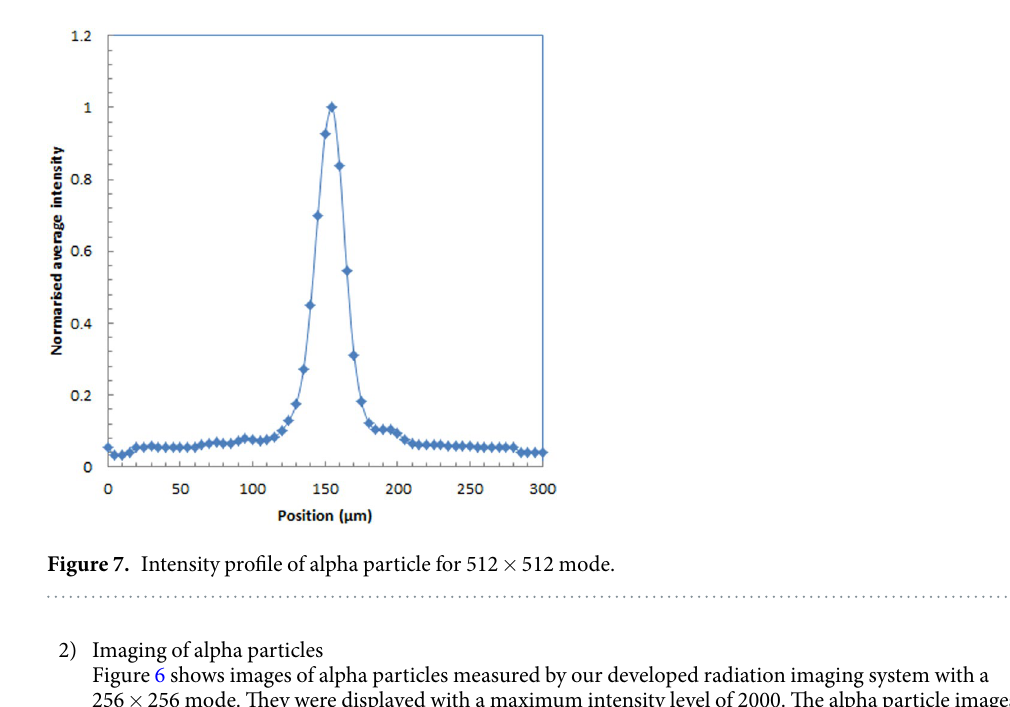
Figure 6. Images of typical alpha particles measured by developed imaging system.